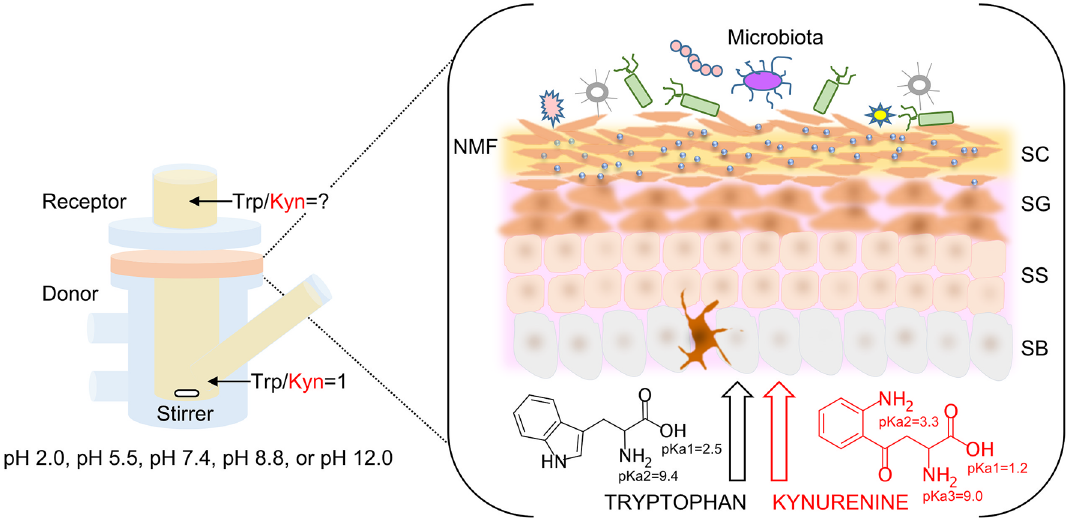
Figure 1. Schematic representation of the in vitro Franz cell setup. NMF natural moisturizing factor, SC stratum corneum, SG stratum granulosum, SS stratum spinosum, SB stratum